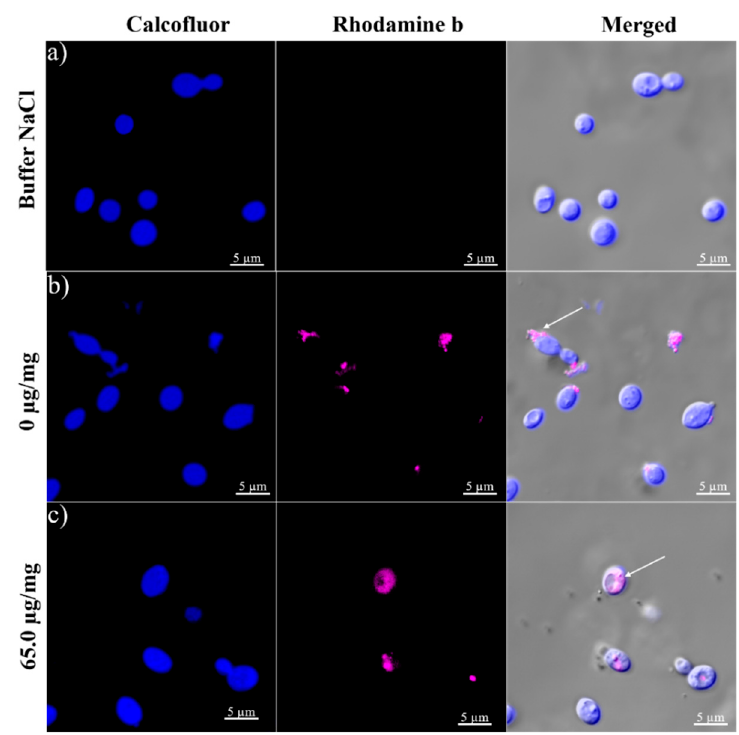
Figure 11. BSA-capsaicin nanoparticle uptake by cultures of R. mucilaginosa . ( a ) Treatment with NaCl buffer did not show rhodamine B signal. ( b ) Treatment at 0 µg/mg showed nanoparticles aggregated on the surface of cells (see white arrow). ( c ) Accumulation of the BSA-capsaicin nanoparticles staining with rhodamine B into the R. mucilaginosa cell was observed at 65.0 µg/mg.